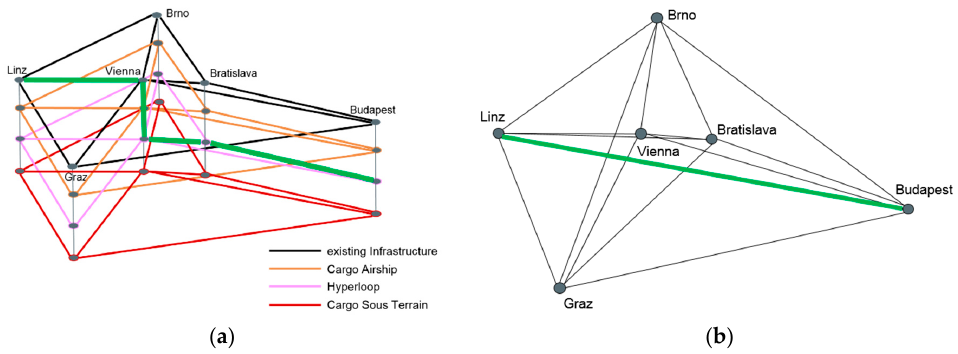
Figure 1. ( a ) Example of an infrastructure network graph; ( b ) Example for a service network graph.